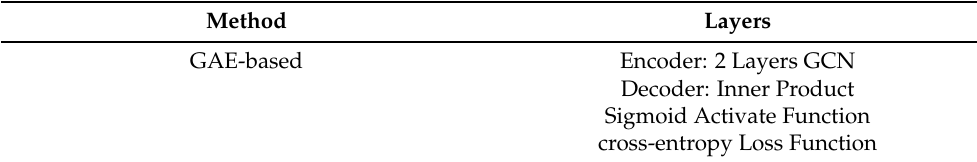
Figure 4. The structure of link prediction model GAE. Table 3. The architecture of the link prediction model